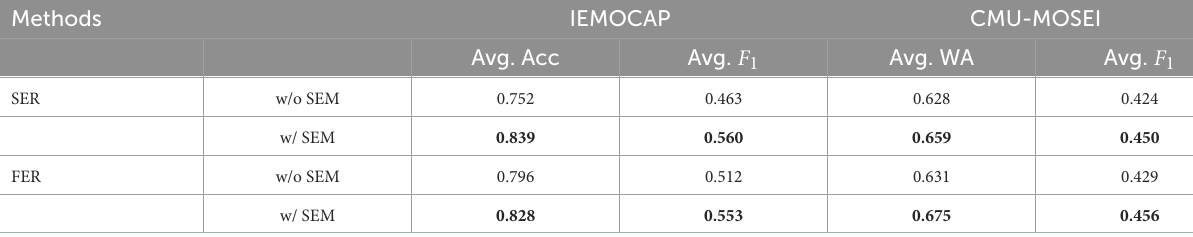
TABLE 4 Unimodal audio/visual emotion recognition results with and without SEM.